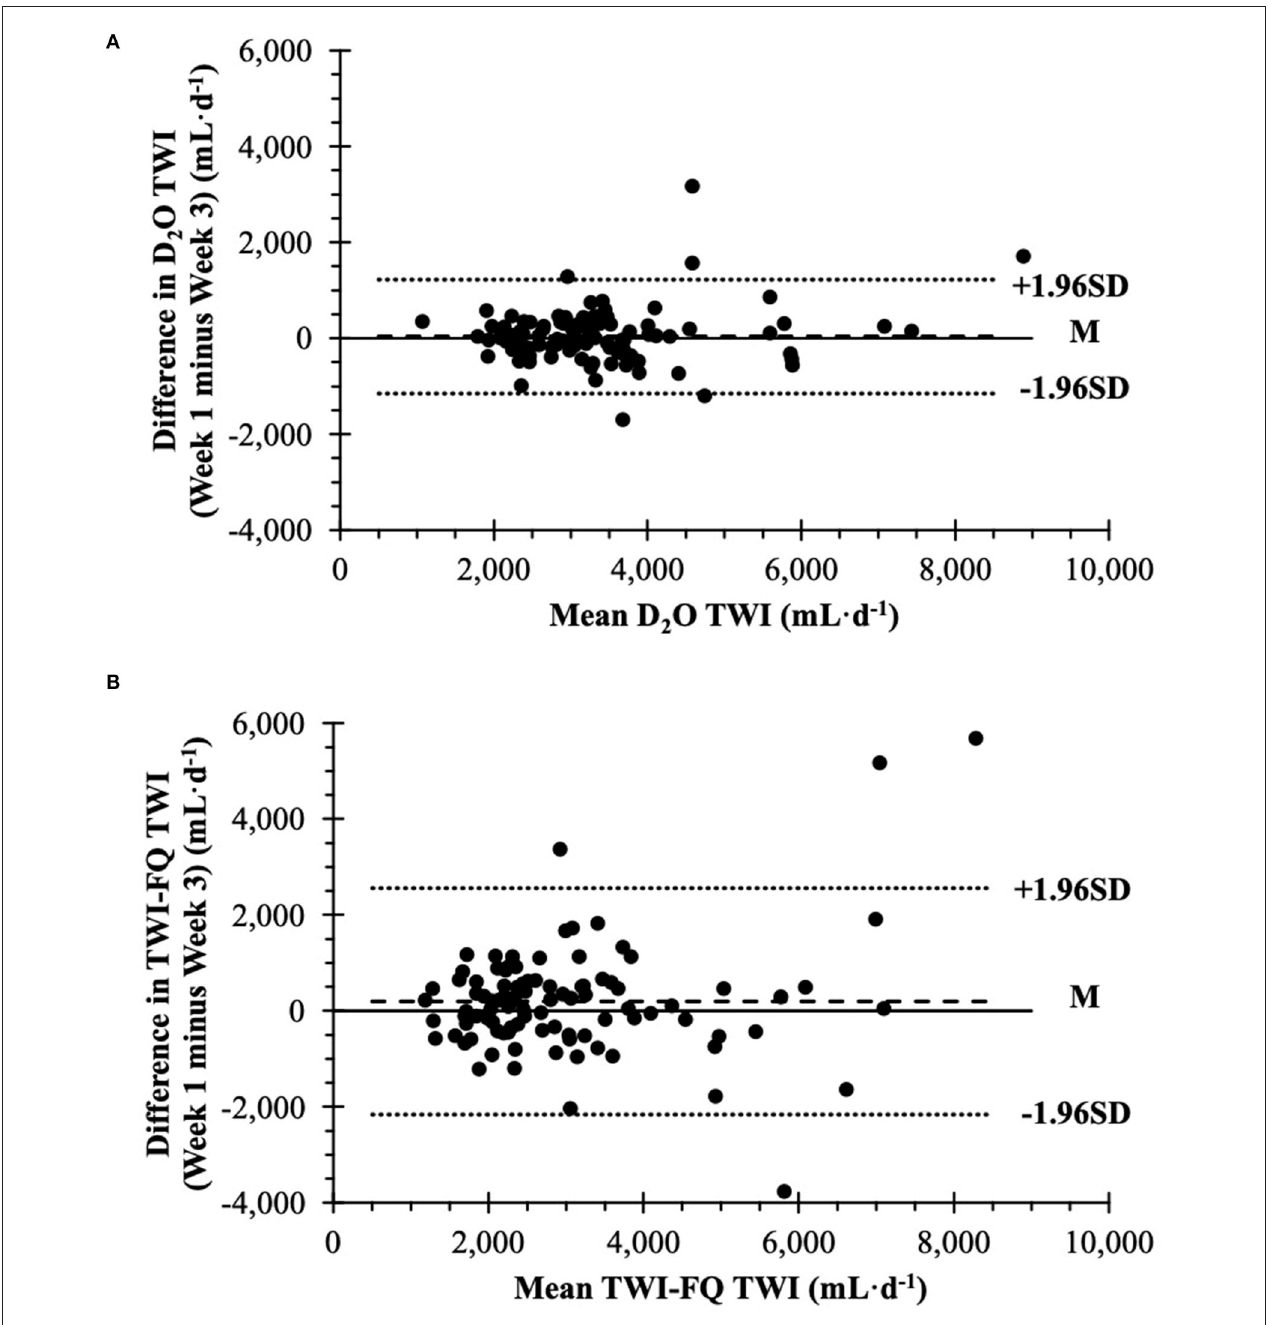
FIGURE 3 | Bland-Altman plots of agreement between repeated estimates (week 1 and 3) of mean daily total water intake via (A) deuterium oxide dilution method and (B) total water intake frequency questionnaire ( n 196). TWI, mean daily total water intake; TWI-FQ, total water intake frequency questionnaire; D 2 O, deuterium = oxide dilution method; M, mean difference between weeks (bias); SD, standard deviation of the mean